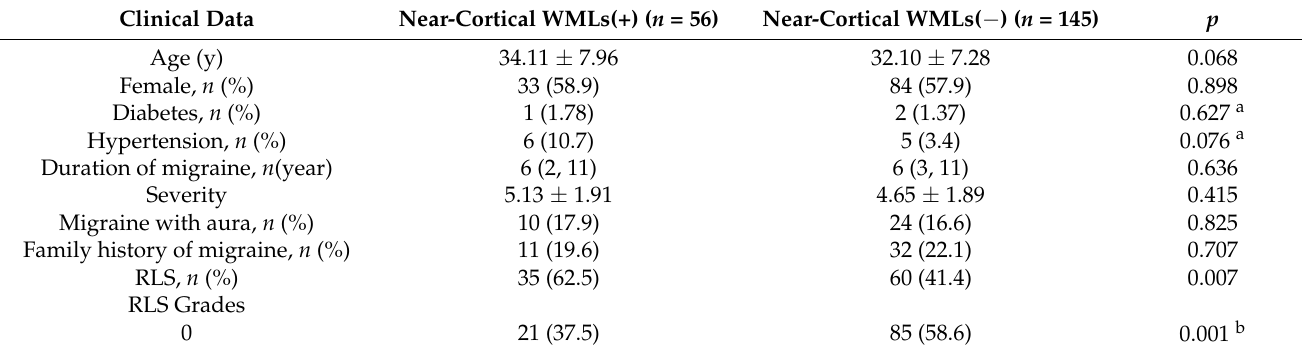
Table 2. Comparison of characteristics between the near-cortical WML-positive and WML-negative groups. Clinical